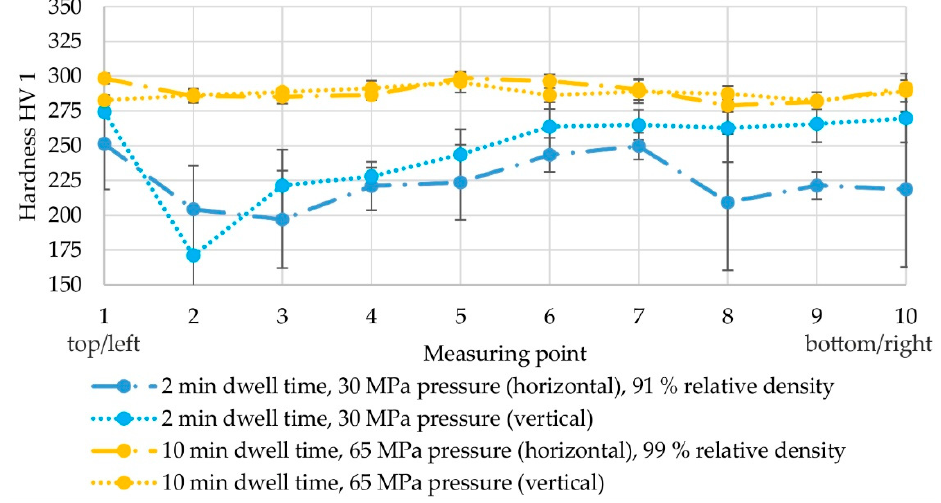
Figure 7. Hardness profiles in vertical and horizontal direction from top or left to bottom or right of the samples of GE48, sintered at 1200 °C.